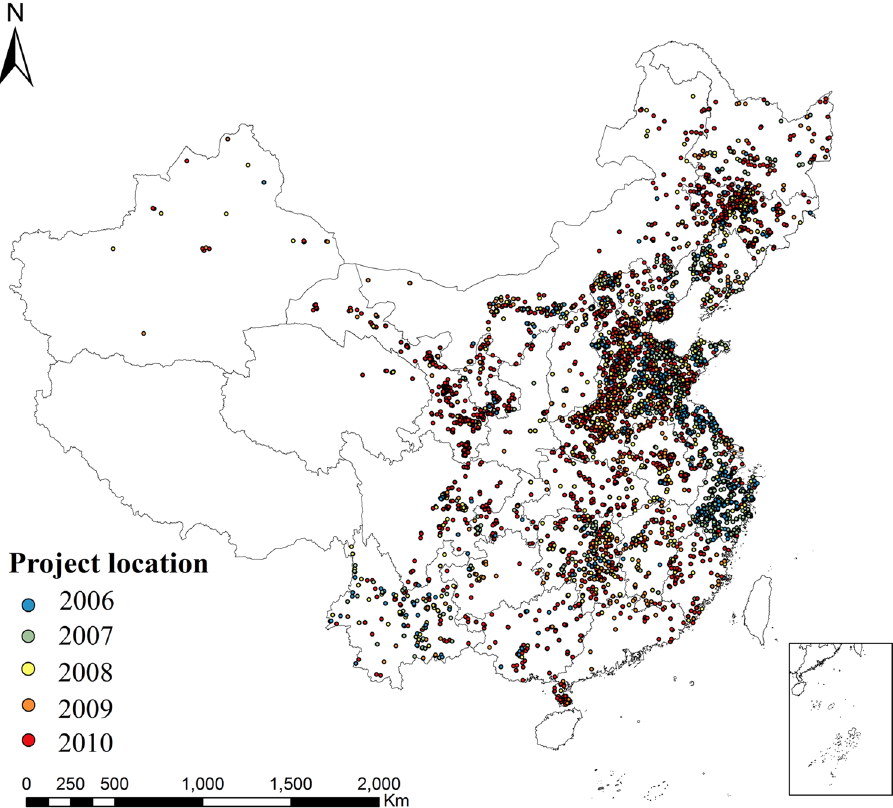
Figure 5. Location of selected land consolidation projects. Map was generated using ArcGIS 10.3 (http://www.esri.com/). Notes: The average size of selected land consolidation parcel was 5.56 km 2 and the largest project covered an area of 69.64 km 2 . Among the selected 5328 projects, the earliest projects (n = 560) completed in 2006 and the latest projects (n = 2376) completed in 2010. By provinces in China, Shandong completed a highest number of 824 projects (total area = 3549.49 km 2 ), and Tibet and Hainan did not complete any project during 2006 to 2010. On average, land consolidation projects in Jilin and Guizhou had the largest (11.86 km 2 ) and smallest (1.92 km 2 ) mean parcel size, respectively. The selected land consolidation projects can be further grouped to three types described previously: a total of 4162 projects focused on farmland consolidation, the average parcel size was 5.80 km 2 ; another 1053 projects focused on land exploitation with average parcel size of 4.88 km 2 ; the remaining 113 projects focused on land reclamation and the average parcel size was 3.15 km 2